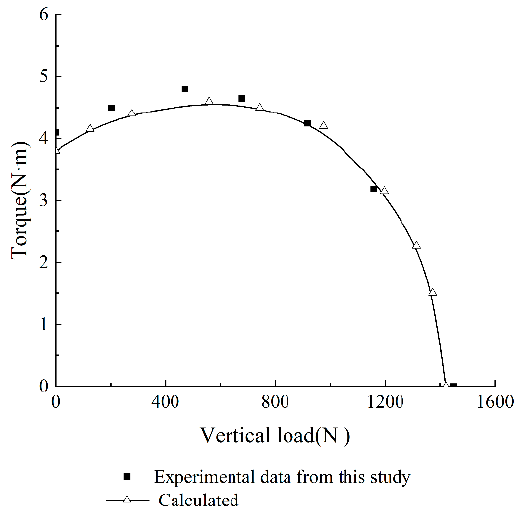
Figure 11. Comparison of single pile bearing capacity envelope with test data under V → T loading path.